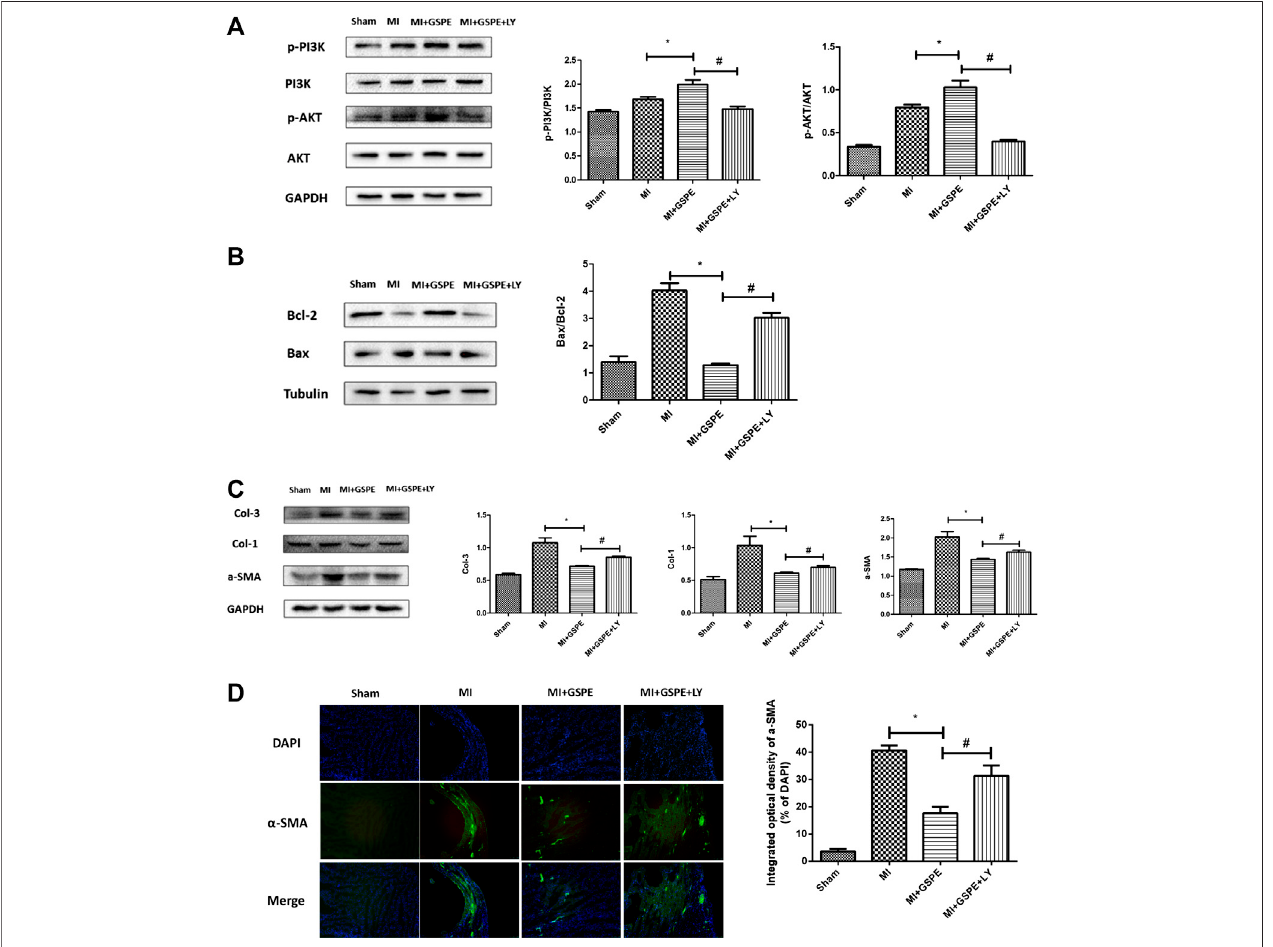
FIGURE 5 | Inhibition of PI3K/AKT pathway can reverse the anti-apoptosis and anti- fi brosis effects of GSPE. (A) Effects of GSPE treatment on cardiac levels of p-PI3K, PI3K, p-AKT evaluated by Western blot analysis. (B) Effects of GSPE on the levels of Bax and Bcl-2 evaluated by Western blot analysis. (C) Effects of GSPE on the levels of Col-1, Col-3 and a-SMA evaluated by Western blot analysis. (D) Immuno fl uorescence staining of a SMS. *Signi fi cant difference comapred with the MI froup, p < 0.05; #signi fi cant difference compared with the MI + GSPE group, p < 0.05. n (cid:2) 3 per group.